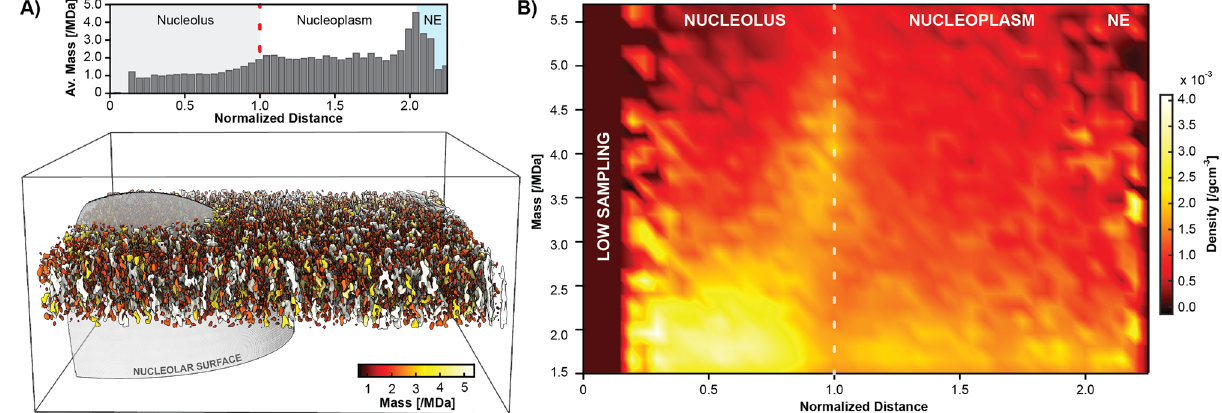
Fig. 2 Image-based analysis of the nucleolar organization. A Individual tomograms can be denoised 50 and fi ltered to allow segmentation of nuclear particles (bottom). Analysis of their apparent mass (top) shows an increase in apparent mass per particle toward the surface of the nucleolus starting at ~0.75 of the normalized distance. Before and after that, the average mass remains relatively constant until the nuclear envelope is reached. B Spectral analysis of particle mass vs. normalized distance over all tomograms with sphere fi ts shows two main features: 1. There are constantly high levels of particles up to a size of ~2.5 MDa, except around the surface of the nucleoli (dashed line). 2. At this distance, a lack of smaller masses is compensated by a burst of large complexes, consistent with the detection of pre-ribosomal particles such as the SSU processome and the pre-60S. NE Nuclear envelope. Source data are provided as a Source Data fi